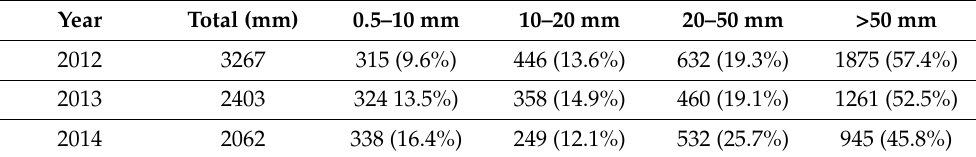
Table 1. Rainfall event characteristics in the study area. Numbers in parentheses indicate percentages of annual